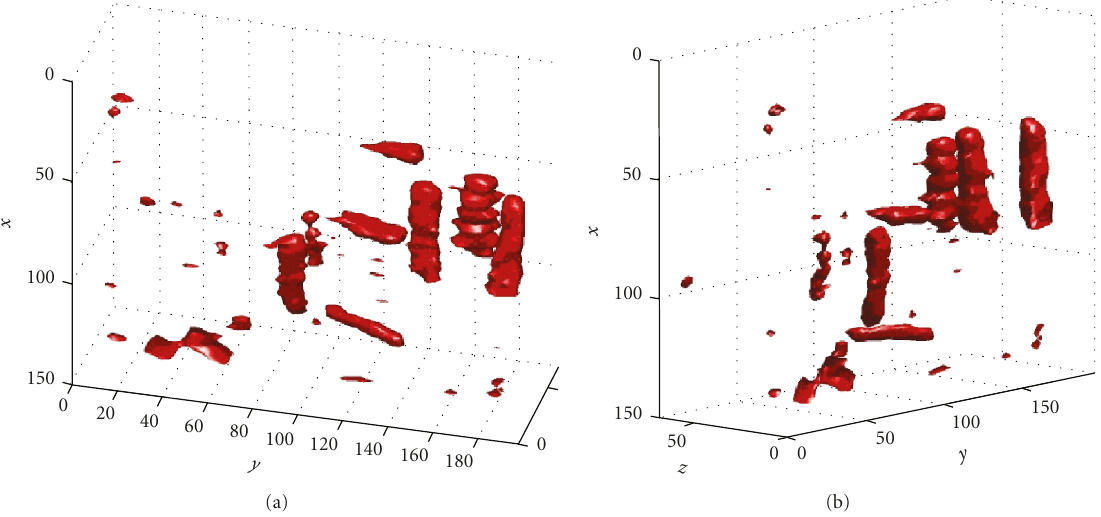
Figure 8: 3D reconstruction of the joints that were used to connect the marble fragments when the monument was rebuilt in the 20th century. Data collected by sliding a 1GHz antenna over a cardboard in order to preserve the integrity of the delicate carvings that decorate the explored wall. The focused data are displayed by showing from two di ff erent perspectives the 3D contour of an iso-amplitude surface. Dimensions are indicated in